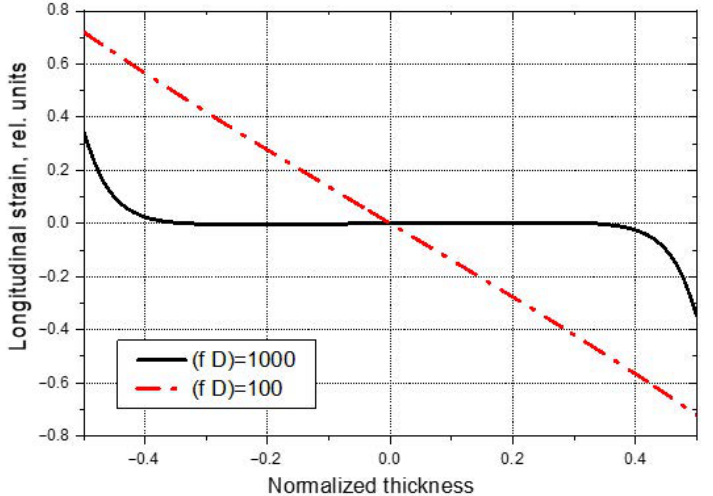
Figure 5. Depth distribution of longitudinal strain in UD-CFRP at two different frequencies.